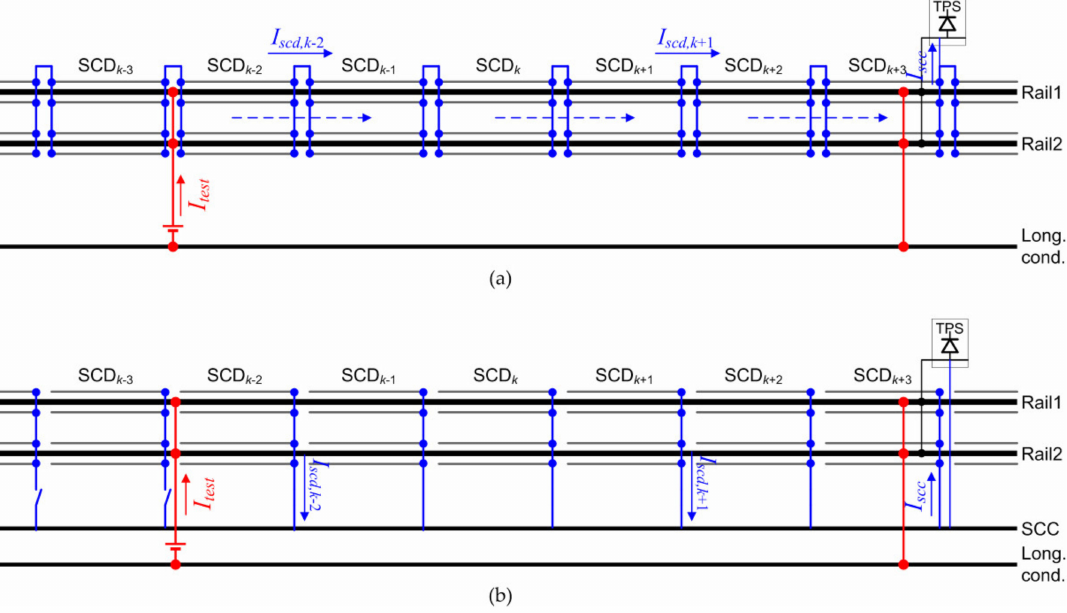
Figure 4. Typical SCPS arrangements and measurement of SCP e ffi ciency: ( a ) SCPS without SCC and daisy-chained SCDs; ( b ) SCPS with SCC and isolated SCDs. SCPS elements are in blue; the test circuit is in